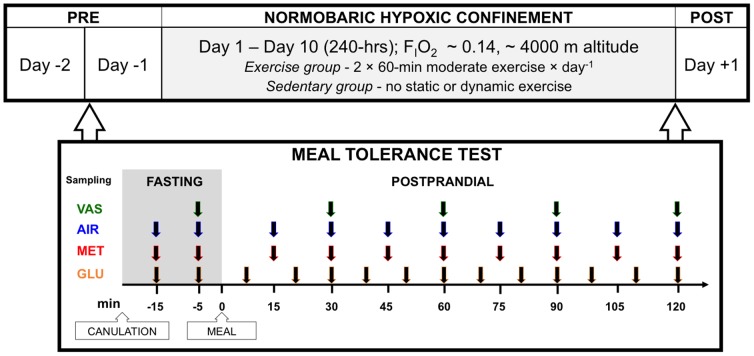
Study protocol and meal tolerance test outline.The meal tolerance test (MTT) was performed in the morning, one day before (Day -1) and just prior to exiting the 10-day confinement (morning of Day +1). FIO2, Fraction of inspired oxygen; VAS, Visual analogue scale for perceived appetite rating; AIR, Exhaled air sampling for determination of 13C isotope; MET, Blood sampling for determination of metabolic markers: total ghrelin, peptide YY, Glucagon-like peptide-1 and insulin at all samplings and leptin, adiponectin, free fatty acids, triacylglycerols, cholesterol, and catecholamines during fasting samplings only; GLU, Blood sampling for plasma glucose concentration determination.